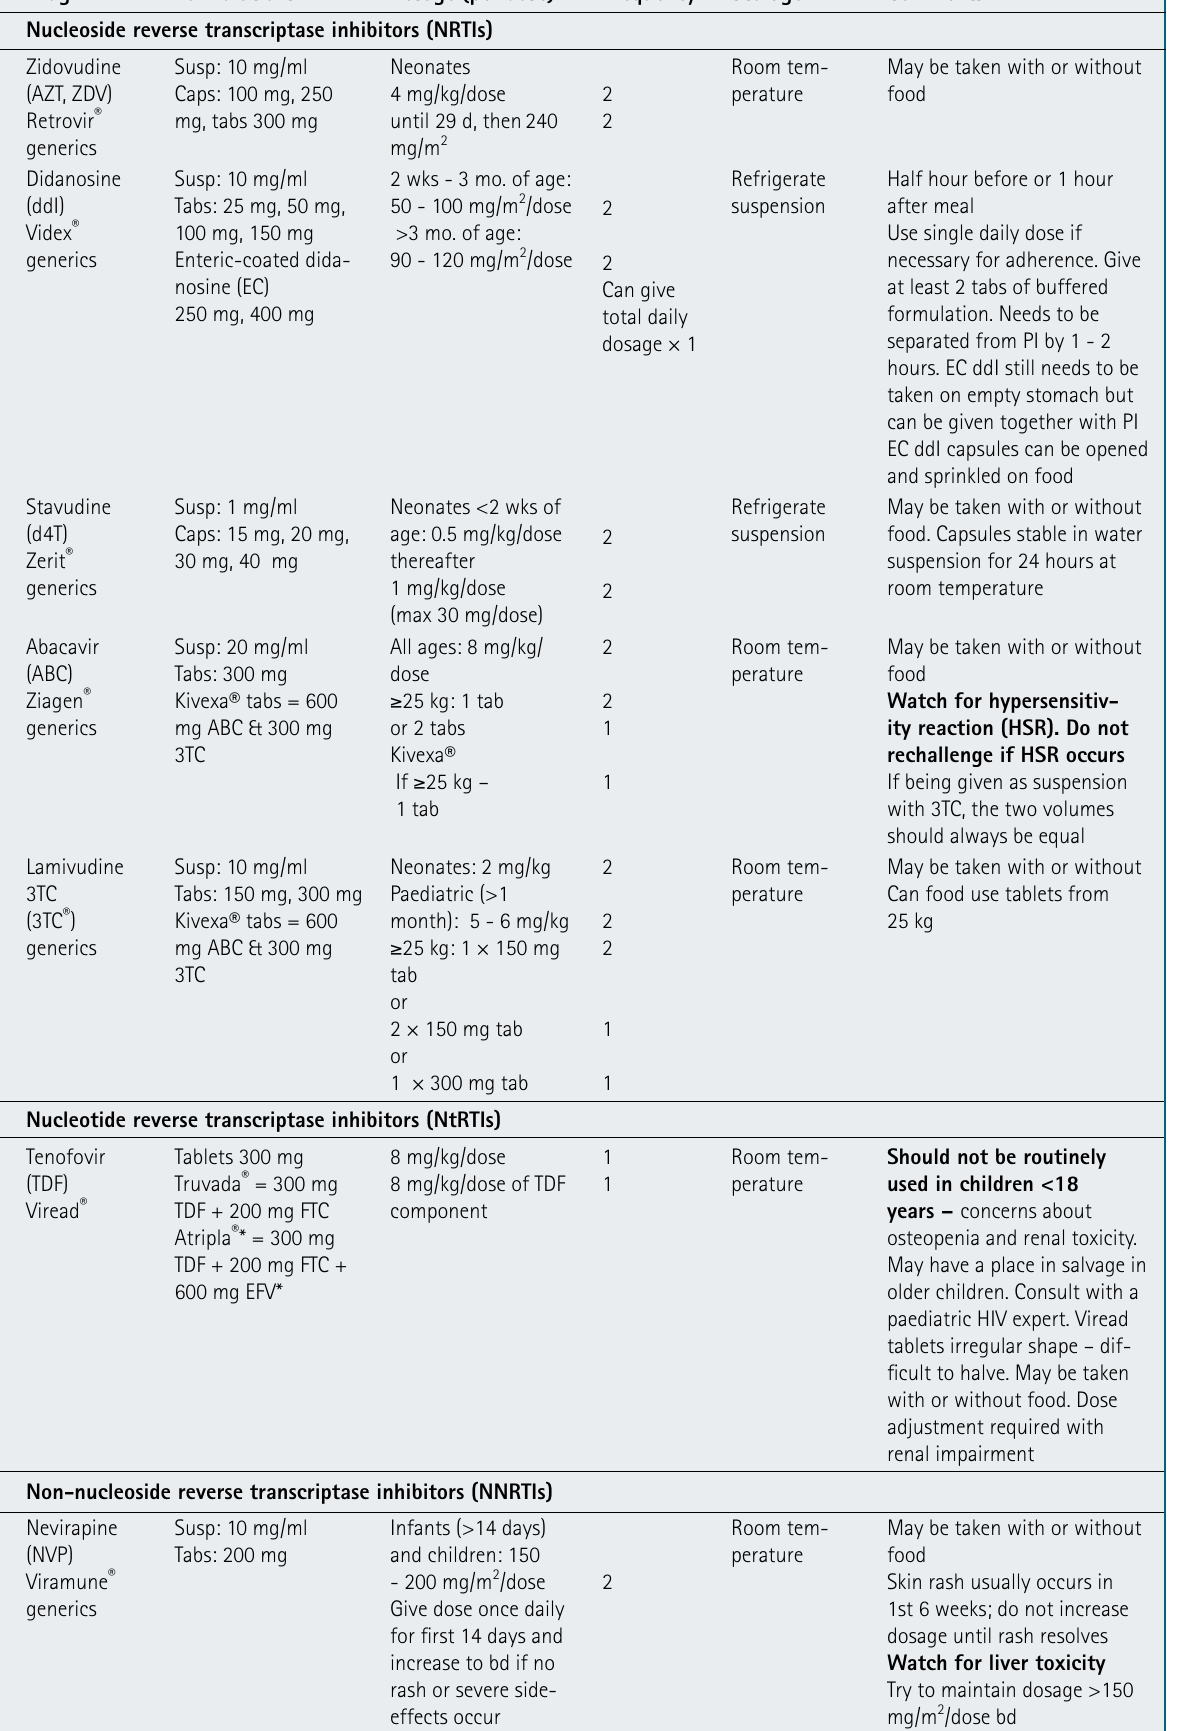
TABLE V. DOSAGE AND FREQUENCY OF ARVs IN